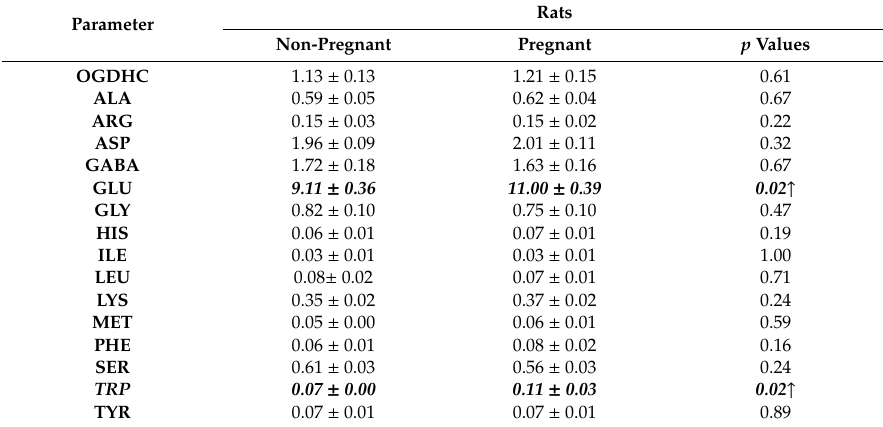
Table1. Influenceofpregnancyonthelevelsofcerebellaraminoacidsand2-oxoglutaratedehydrogenase complex (OGDHC)